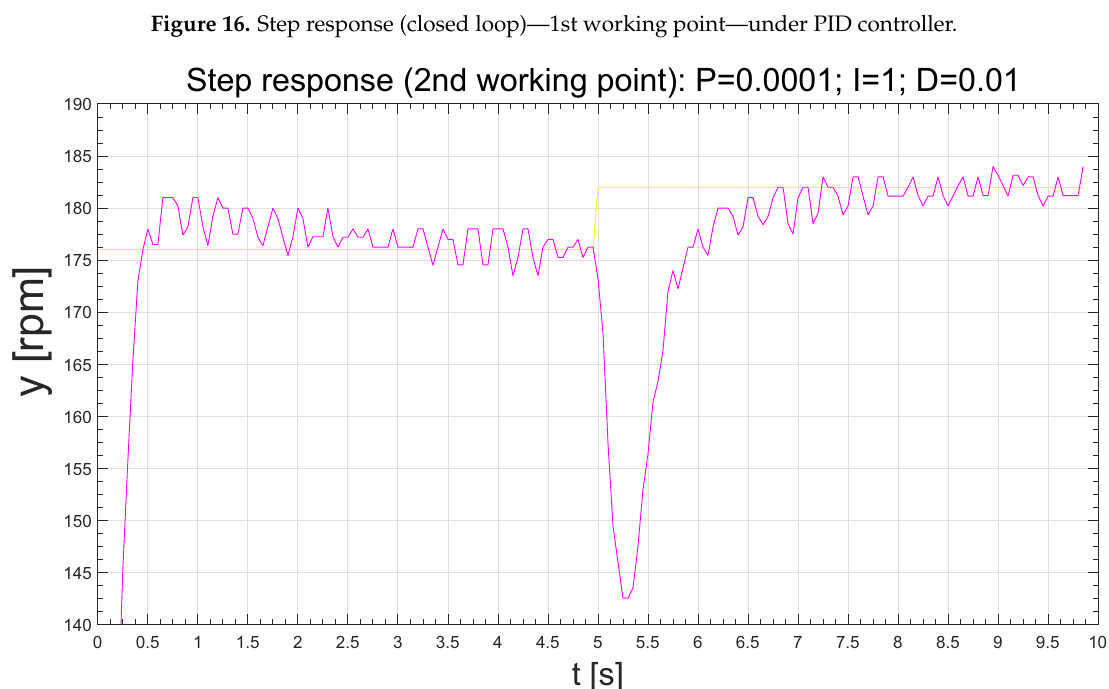
Figure 17. Step response (closed loop)—2nd working point—under inappropriate